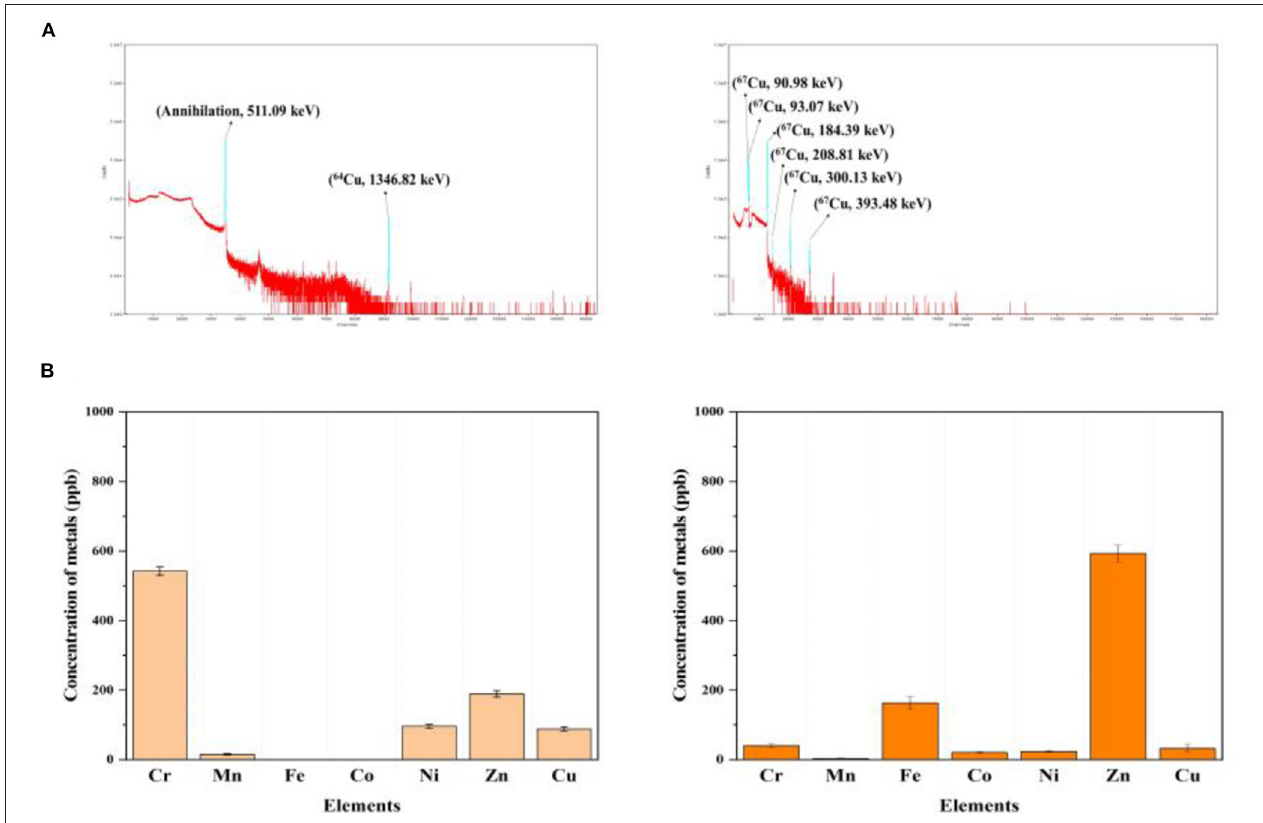
FIGURE 5 | Quality control of pair-radioisotopes (A) gamma energy spectrum of purified 64 Cu (left) and 67 Cu (right), (B) metallic impurity content in purified final volume of 64 Cu (left) and 67 Cu